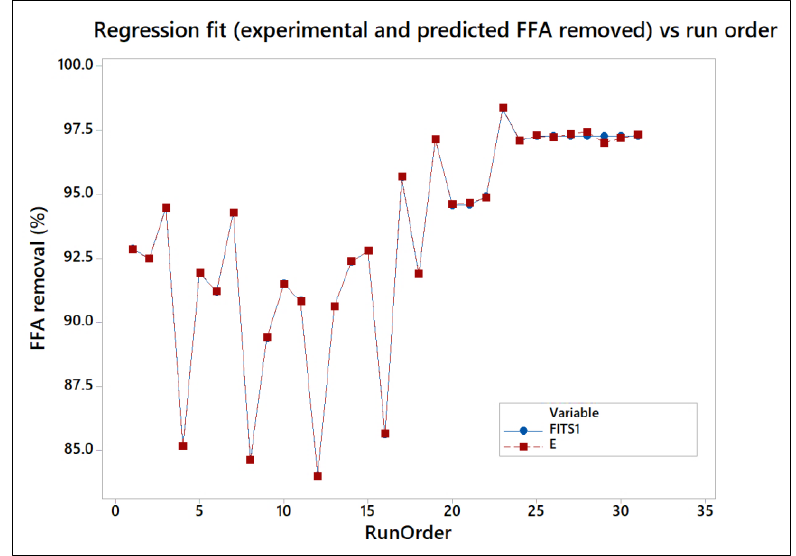
Figure 24. Acidity removed (experimental and predicted) as per the experimental run order.